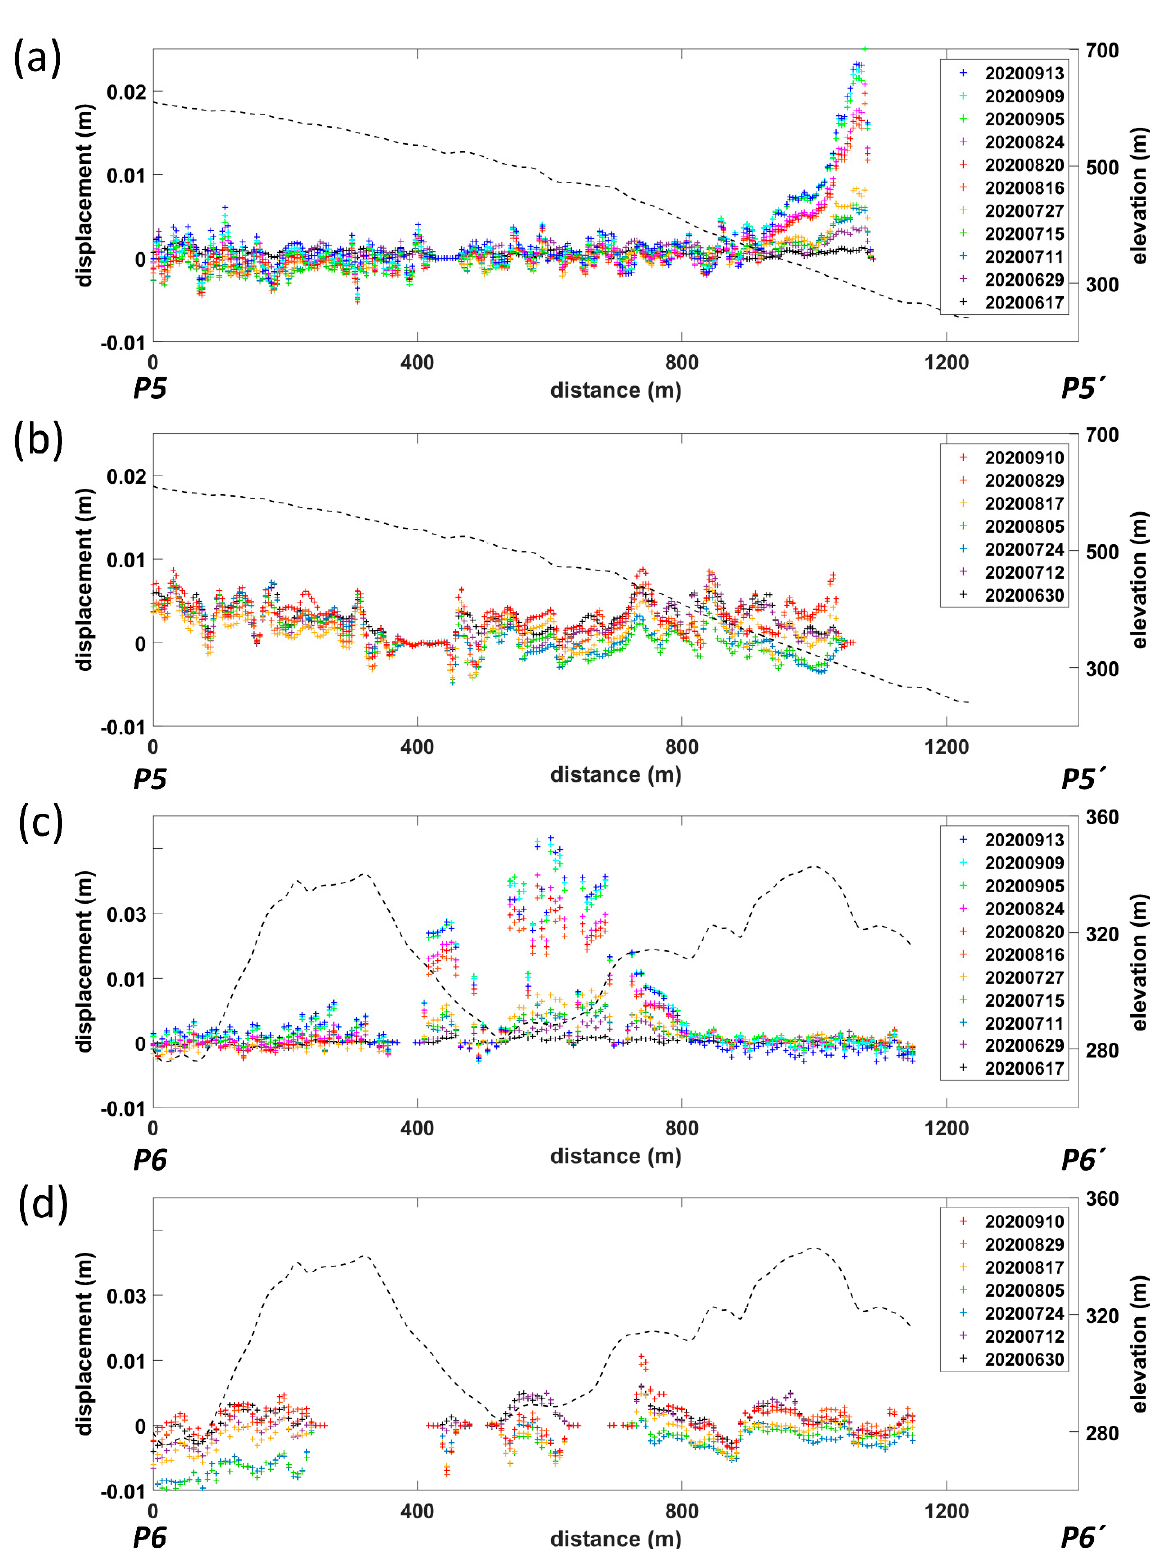
Figure 10. LOS time-series analysis of Site 9 displacement profiles. ( a ) RCM P5-P5 ′ profile, ( b ) Sentinel-1 P5-P5 ′ profile, ( c ) RCM P6-P6 (cid:48) profile, ( d ) Sentinel-1 P6-P6 (cid:48) profile. The black dashed lines represent elevations along the